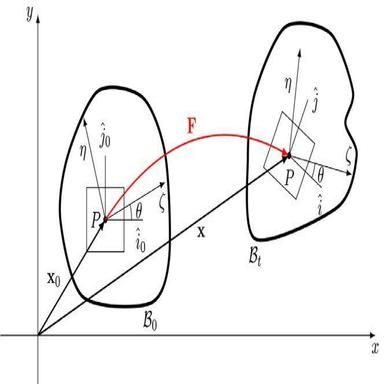
Kinematic of material body at finite strains with the definition of reference and current placement and including the material orientation .